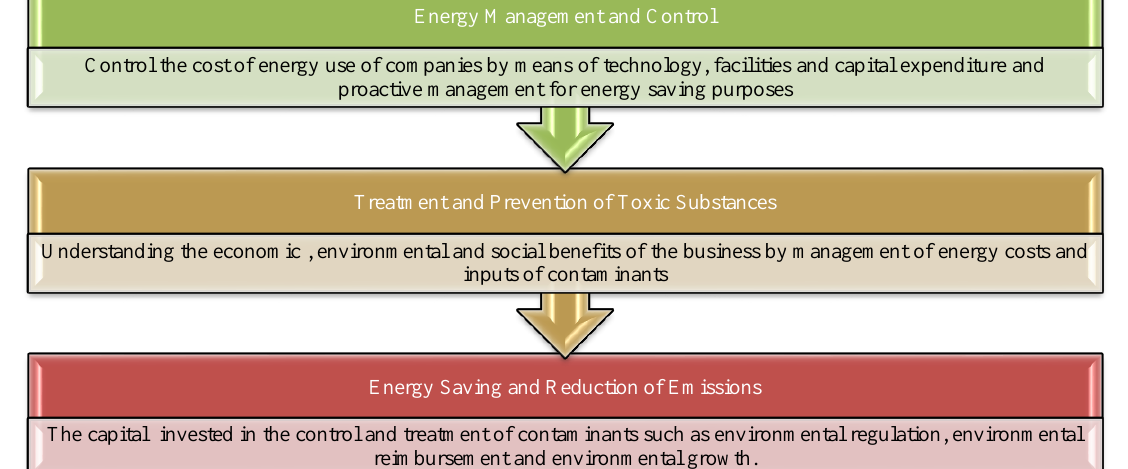
Figure 1. Functions of energy